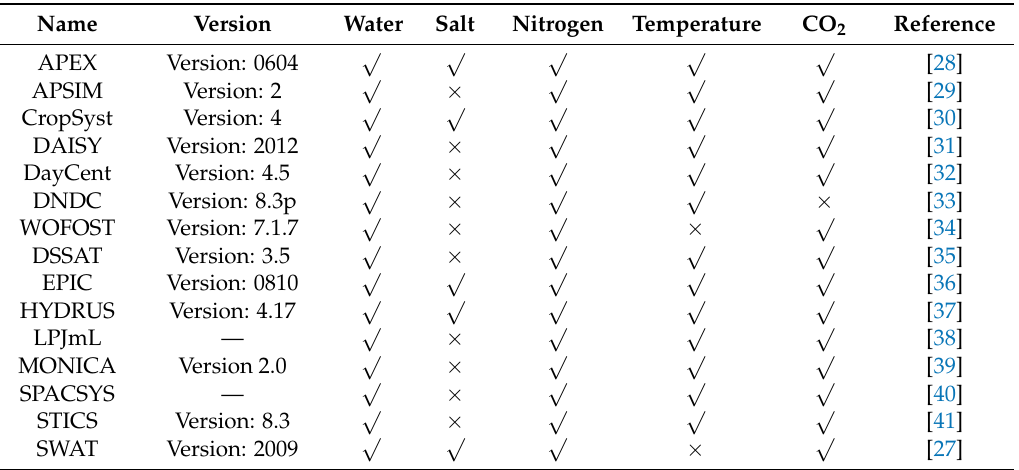
Table 1. Reviews of crop models that consider environmental